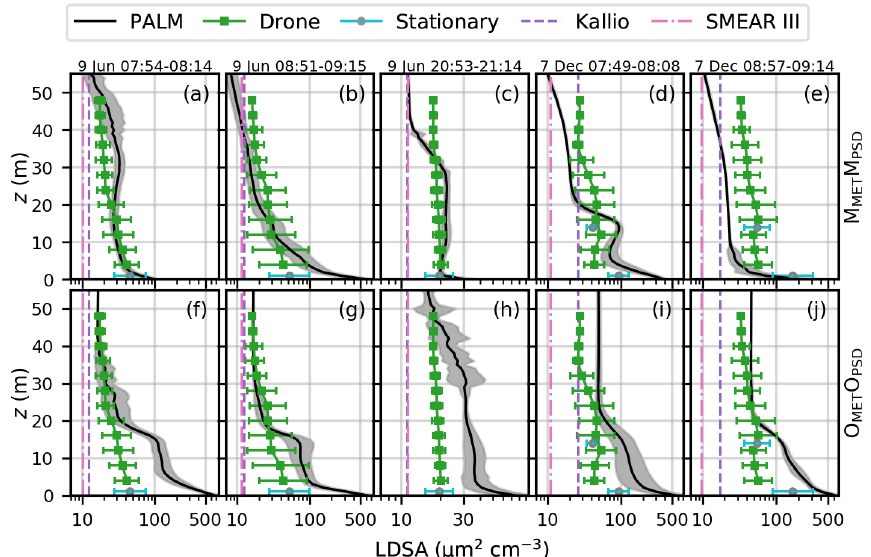
Figure 7. Measured (marker with error bar) and modelled (black line and grey-shaded area) LDSA of aerosol particles opposite the supersite for the summer morning ( a, f for the first and b, g for the second hour), summer evening (c, h) and winter morning ( d, i for the first and e, j for the second hour). The first row shows M MET M PSD and the second O MET O PSD . The figure shows the geometric mean (measured: marker; modelled: solid line) and geometric standard deviation (measured: error bar; modelled: shaded area). Dashed lines show the geometric mean at the urban background monitoring sites in Kallio and SMEAR